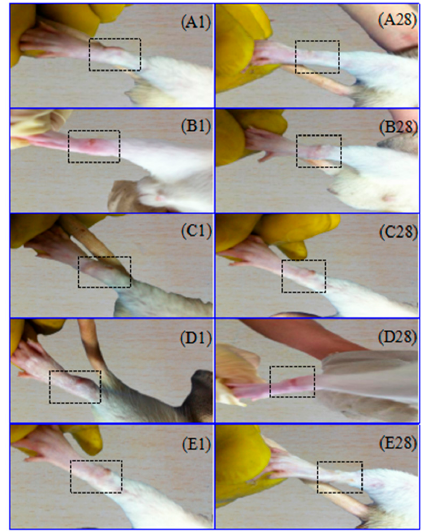
Figure 1. Effects of brucine gel on primary arthritis in adjuvant arthritis (AA) rats. Morphological representations of rat paw indicated the change of pre- and post-treatment in brucine gel high-dose ( A ); brucine gel low-dose ( B ); Yunnan Baiyao powder ( C ); model group ( D ); and blank control group ( E ). Images showed that the paw swelling after injection with Freund’s adjuvant complete (FAC) in the right hind paw on the first day in ( A1 , B1 , C1 , D1 , E1 ). The paw swelling subsided after brucine gel and Yunnan Baiyao powder were treated respectively on the 28th day in ( A28 , B28 , C28 , D28 , E28 ).